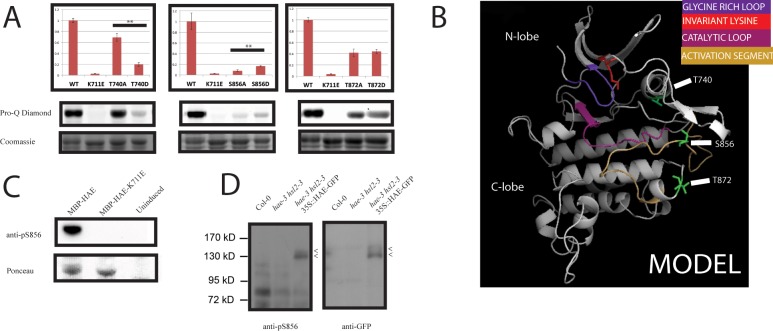
Evidence that S856 is an in vivo phosphorylation site that positively regulates HAE protein kinase activity.A) Quantified in situ auto-phosphorylation levels for alanine and aspartate substitution mutants at 3 in vitro phosphorylation sites averaged over 3 biological replicates. ** = p-value < .01. Error bars represent standard deviation. Tests for statistical significance were carried out by performing a 2 sample t-test. B) Model of HAE protein kinase with selected phosphorylation sites annotated in green. C) Detection of active MBP-HAE by anti-pS856 anti-body in whole cell lysate from MBP-HAE expressing E. coli. D) Specific detection of a protein migrating at the expected size (~130 Kda) with the anti-pS856 and anti-GFP antibodies in protein isolated from Arabidopsis flowers overexpressing HAE-GFP by the 35S promoter. Arrows mark potential phospho-isoforms.